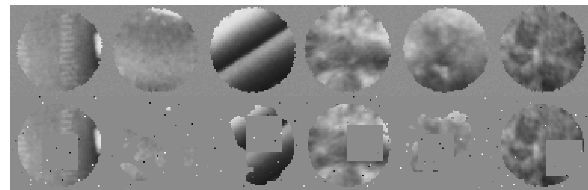
Figure 3. Examples of ground truth height maps (top row) and artificially corrupted images (bottom row) used as input data during